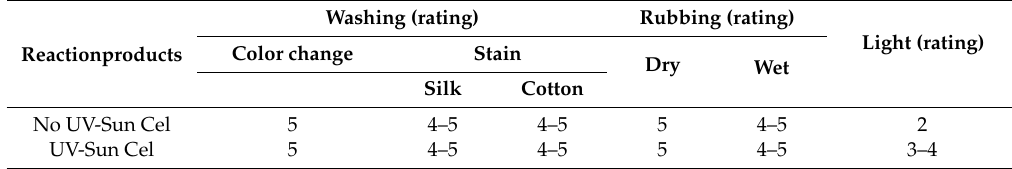
Table 3. Color fastness of silk fabrics dyed with the PGA/Glc reaction products.